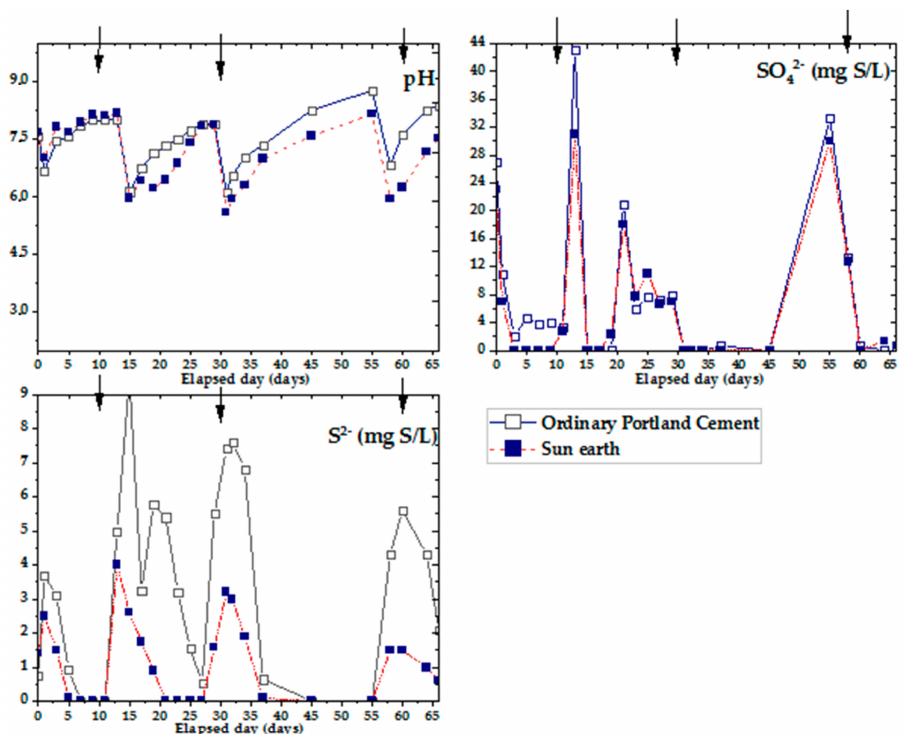
Figure 7. Experimental results of hydrogen sulfide inhibition effect by OPC and San-Earth over time. Arrow ( ↓ ) indicates the addition of glucose (100 mg/L) and magnesium sulfate (33 mg S/L).